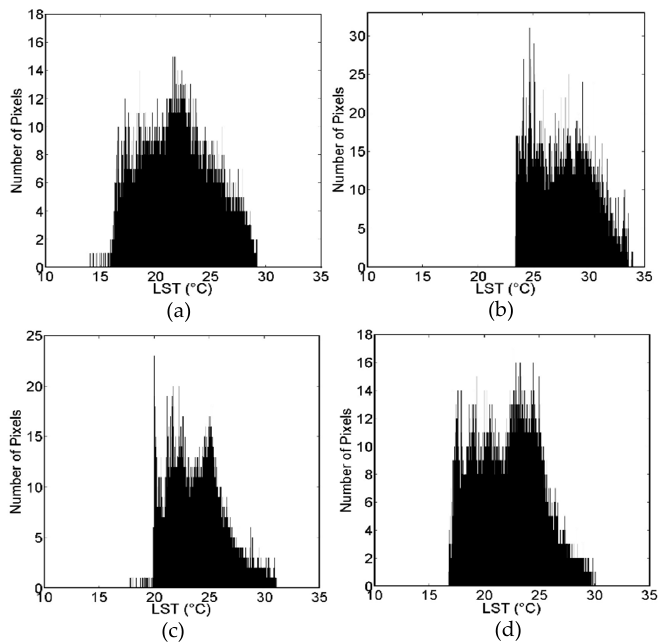
Figure 6. Histograms of LST images from ( a ) Landsat, ( b ) STARFM, ( c ) ESTARFM, and ( d ) STAEFM on 18 January 2019 .